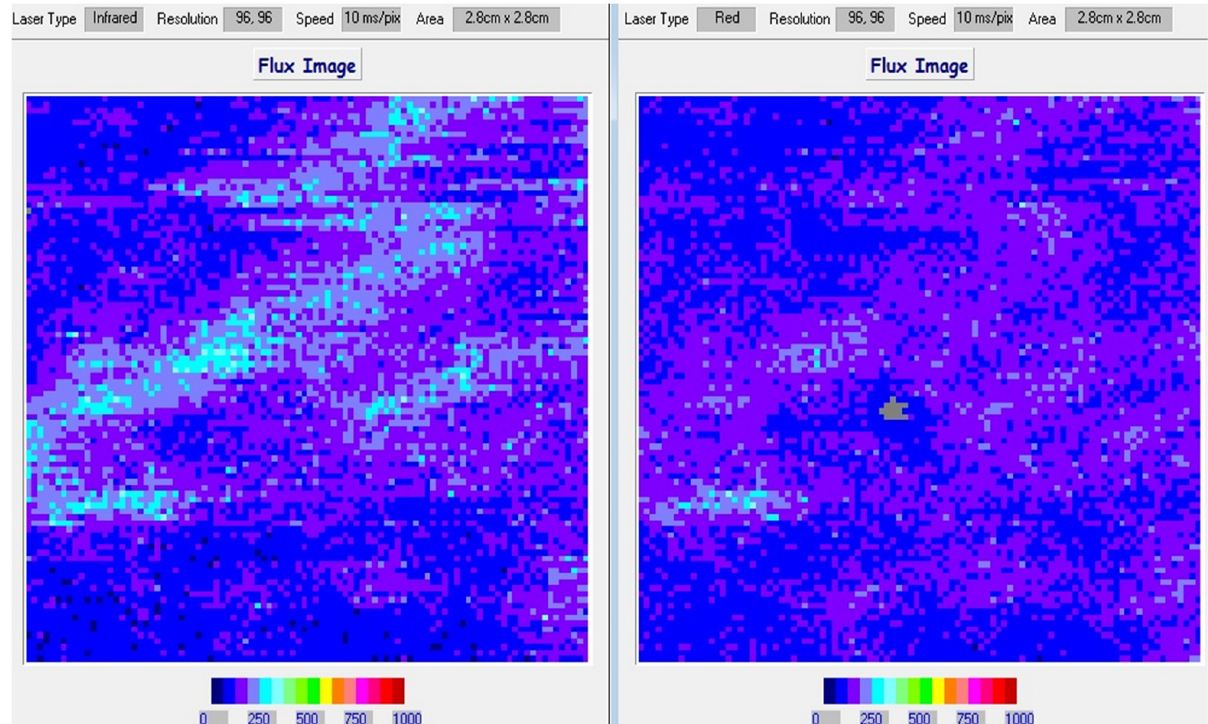
Fig 4. Laser Doppler imaging (LDI). An example of the infrared (left) and visible-red (right) laser blood perfusion images recorded from the site of testing of a 21-year old White British female participant at the time point during-intervention 10 minutes. The point drawn using washable marker can be seen in the centre of the visible-red image.